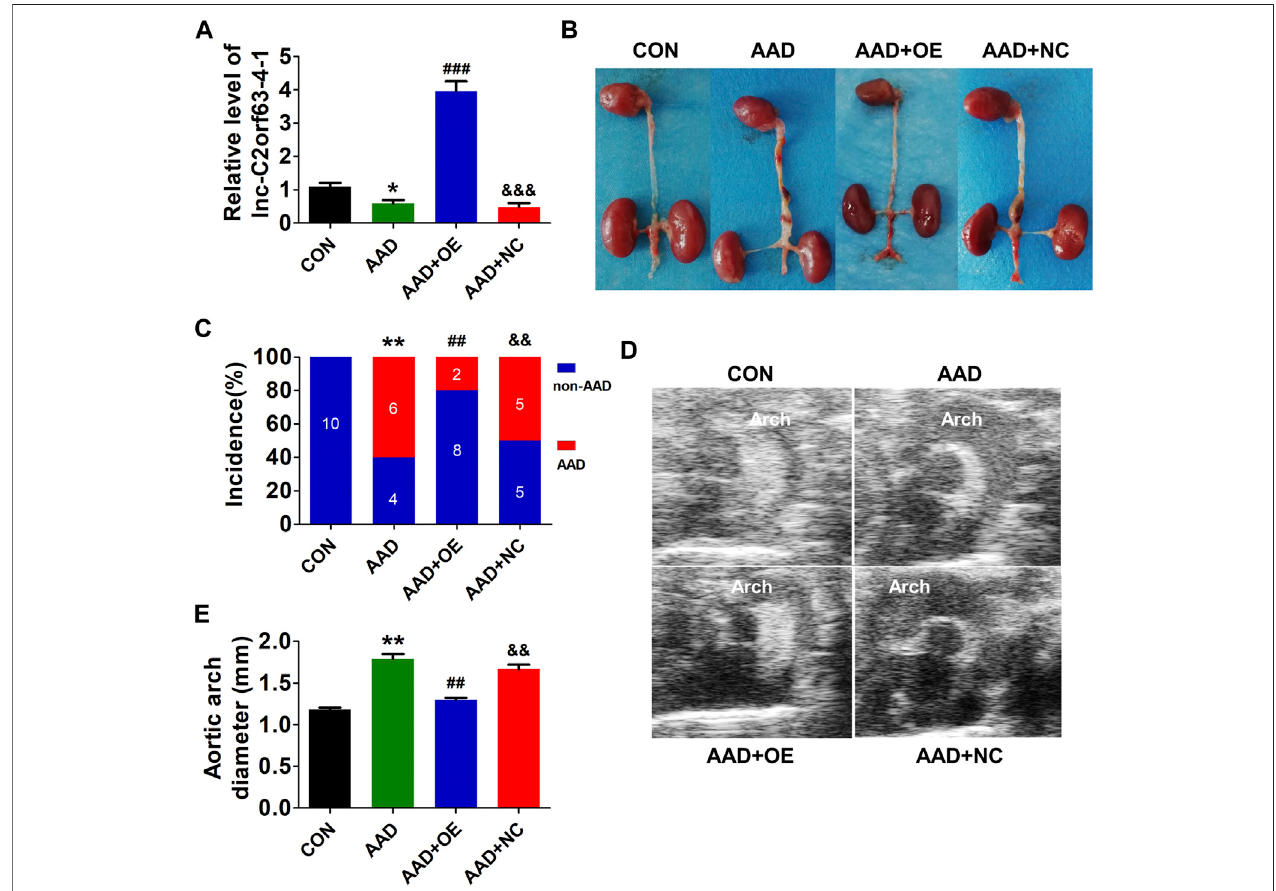
FIGURE4| Invivo targetingoflnc-C2orf63-4-1reducesAngII-inducedAADinApoE − / − mice. (A) Theexpressionoflnc-C2orf63-4-1inaortictissuesinallgroupswasdetectedby qRT-PCR ( n (cid:1) 10/per group). U6 was used for normalization. (B) Representative photographs of AAD in male ApoE − / − mice. AngII (1,000 ng/kg/per min) was chronically infused for 28 days, and saline was used as the control. (C) Incidence of AAD in all groups ( n (cid:1) 10/per group). (D,E) Representative pictures from ultrasonography (D) and quanti fi cation of the maximalaorticarch (E) ofallgroupsattheendof28 dayssalineorAngIIinfusion( n (cid:1) 4 – 10/pergroup).Dataof (A) and (E) werecomparedbyanalysis-of-variance(ANOVA)with Bonferroni ’ spost-test.Incidenceofaorticdissection (C) waspresentedasnumbersandcomparedbyusingFisher ’ sexacttest.* p < 0.05,** p < 0.01vs.controlgroup, ## p < 0.01, ### p < 0.001vs.AADgroup, && p < 0.01, &&& p < 0.001vs.AAD+OEgroup.Datawereallexpressedasmean ± SEM.ConrepresentssalinetreatmentApoE − / − micegroup;AADrepresents aortic dissection and aneurysm model group by ApoE − / − mice treatment with AngII; OE, overexpression of lnc-C2orf63-4-1 by the recombinant adeno-associated virus (serotype 9; AAV9)vectorcarryingthefull-lengthoflnc-C2orf63-4-1gene;NC,negativecontrol fl aggeneengineeredintotheAAV9vector.Theviralconstructswereintravenouslyinjectedintomice.